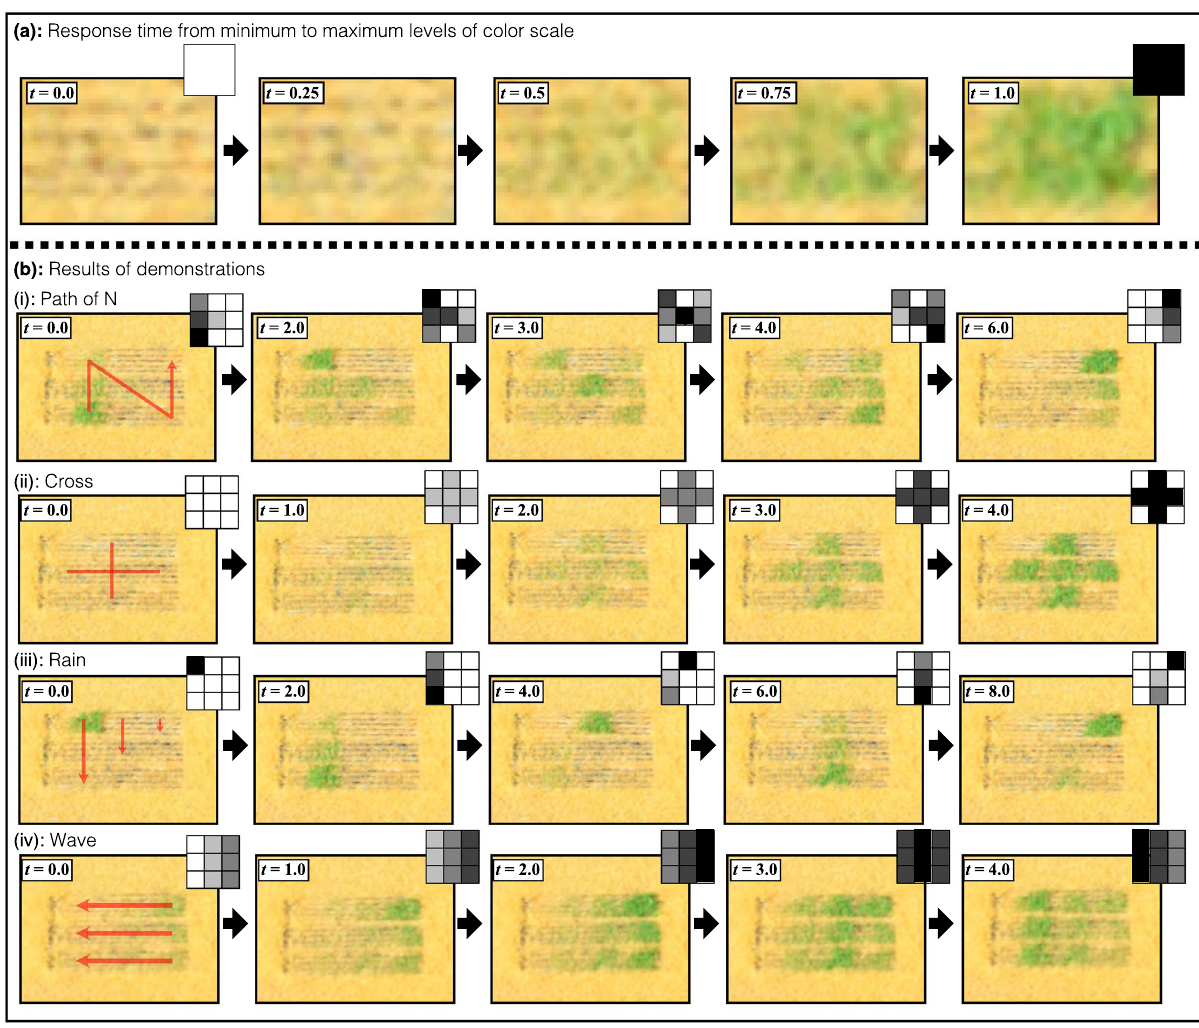
Figure 10. Demonstration results of a 3 × 3 pixels grass animation display using results of grass color scale setting experiments at ( h , d , θ) = ( 1.7, 2.0, 0 ) . ( a ) The response time to change the grass pixel from minimum and maximum of the grass color scale was 1.0 [s]. ( b ) Four animations of (i) path of letter N, (ii) cross, (iii) rain, and (iv) wave were played on the pixels grass animation display. This figure was created using Serif Affinity Designer version 1.10.0 (https:// affin ity. serif. com/ en-